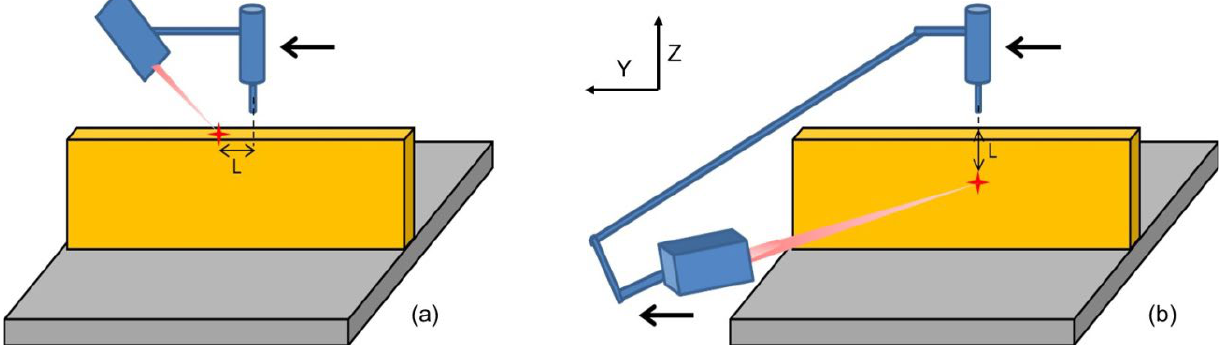
Figure 2. Strategies for interlayer temperature (IT) measurement in thin-wall WAAM: ( a ) Upper Pyrometer strategy; and ( b ) Sideward Pyrometer strategy.